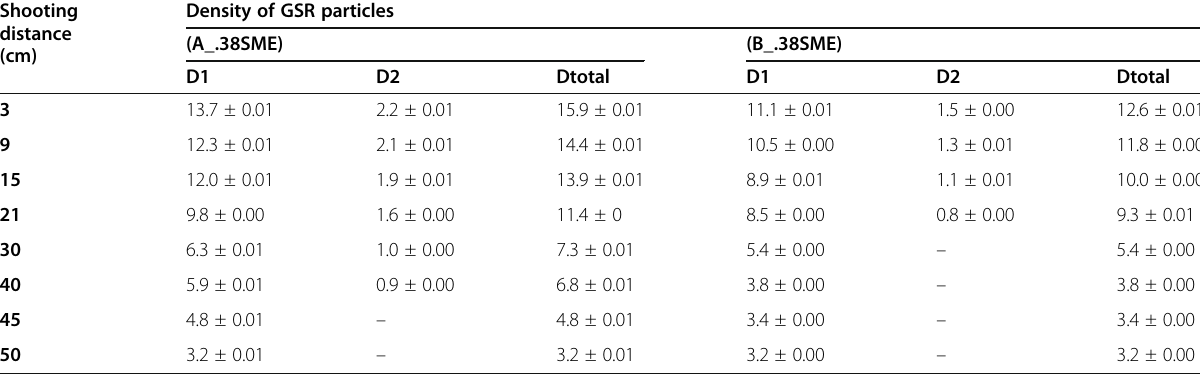
Table 1 Density of GSR particles vs. shooting distance data for (A_.38SME) and (B_.38SME) revolver at different shooting distances Shooting distance